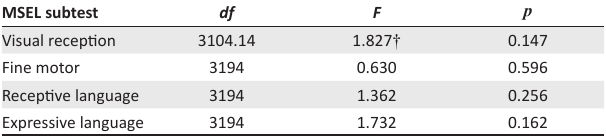
TABLE 3: One-way analysis of variance results for each Mullen Scales of Early Learning subtest by language